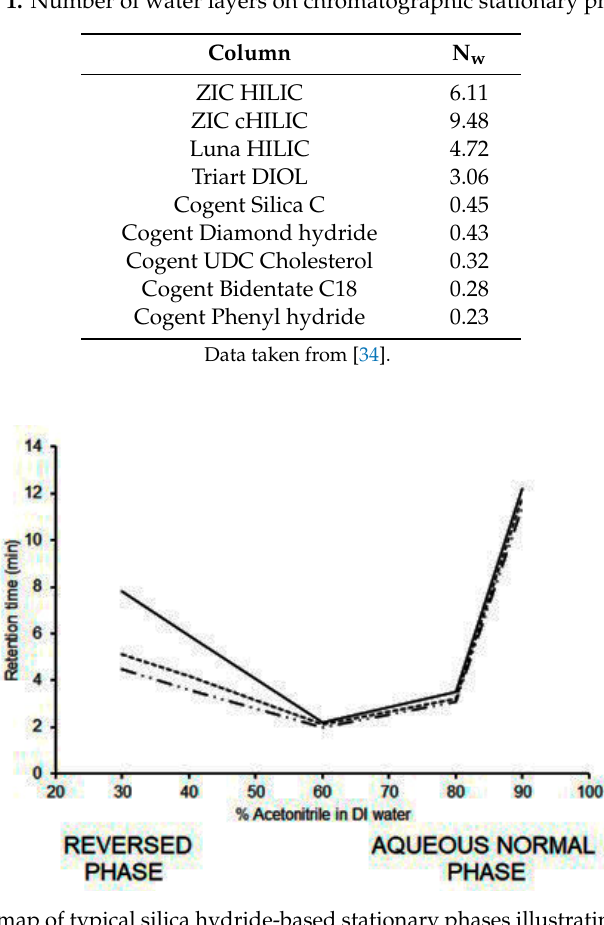
Figure 4. Retention map of typical silica hydride-based stationary phases illustrating the dual retention properties of these materials.